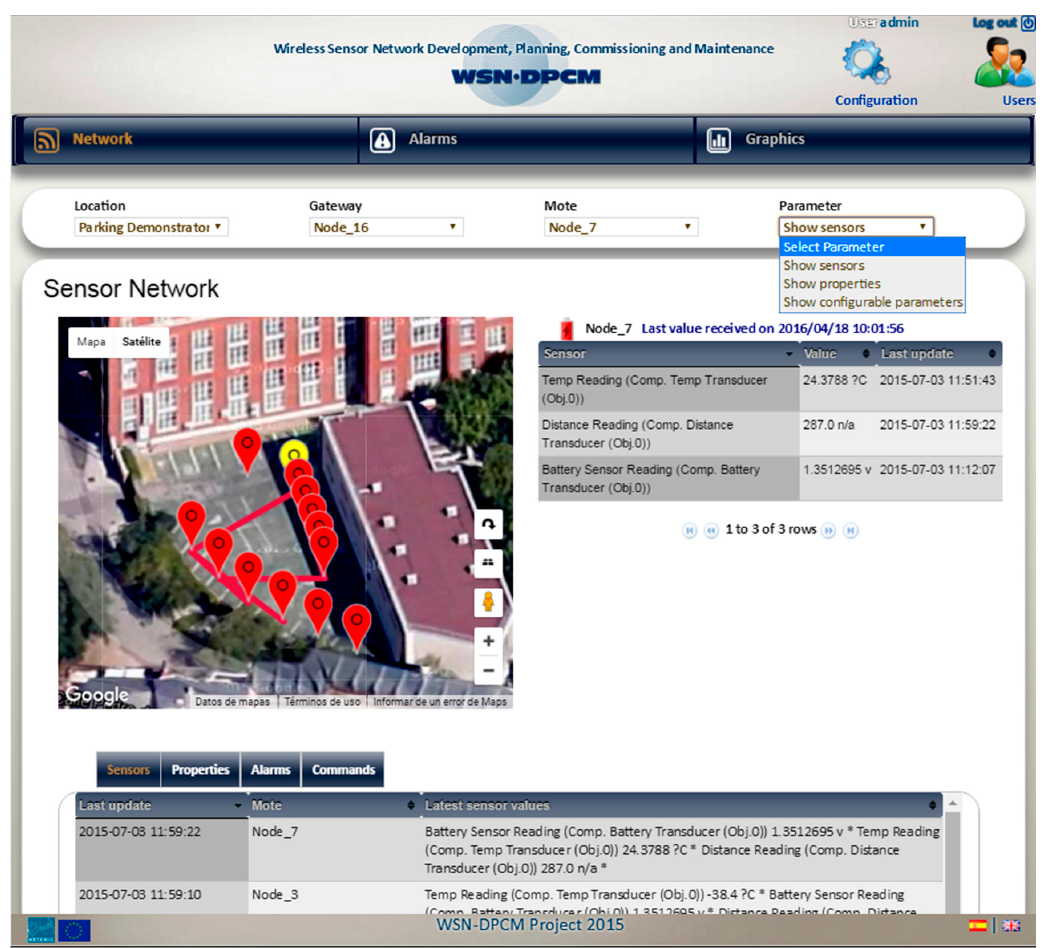
Figure 22. General view of the top-level interface of the Commissioning and Maintenance Tool Web Application.